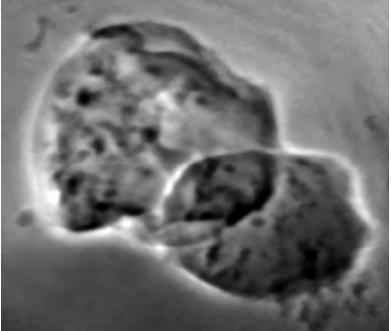
Figure 20. Refractive index micrograph of EMT (Epithelial-Mesenchymal Transition cells with gold